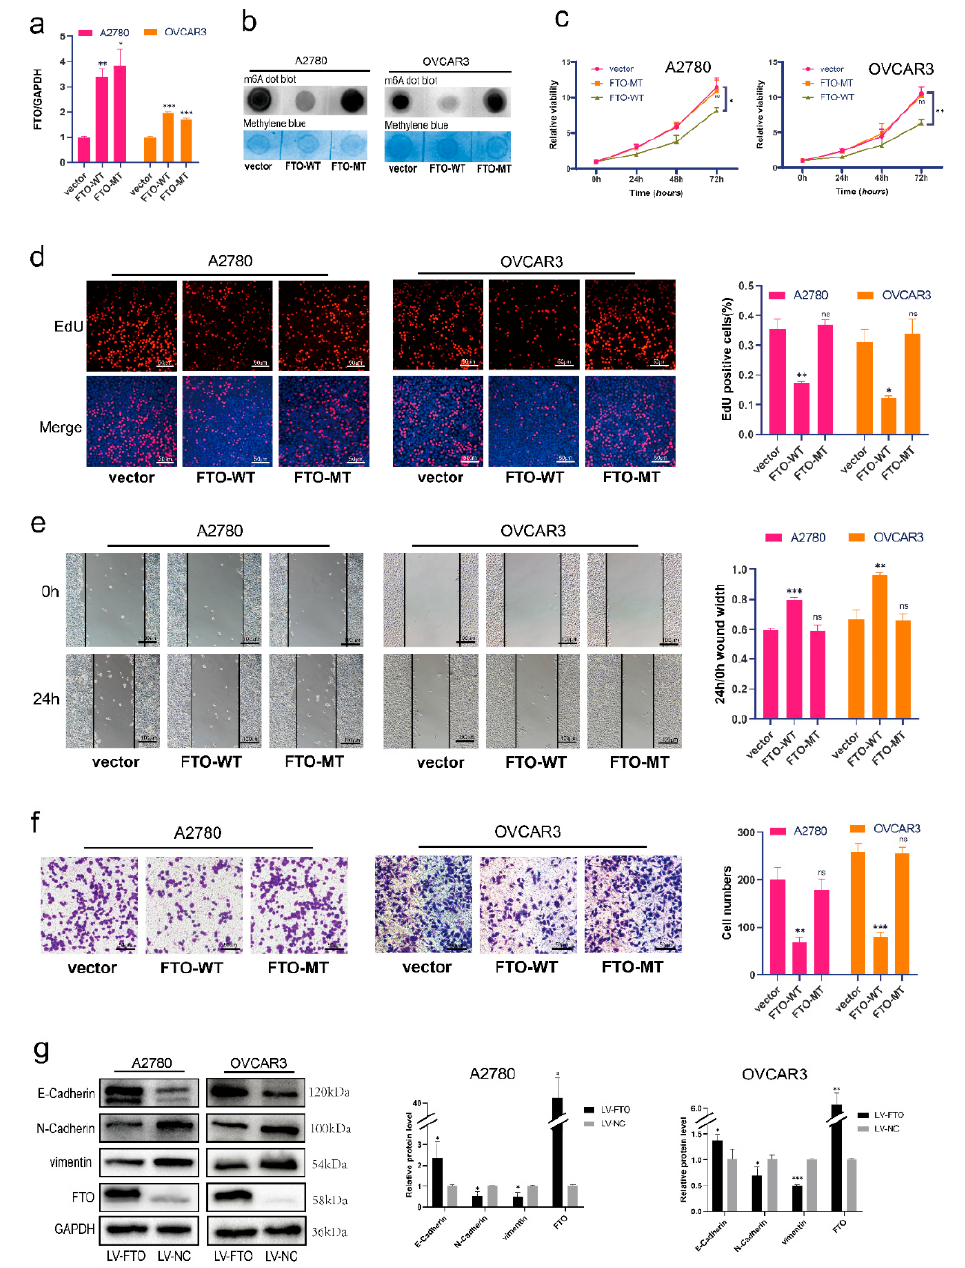
Figure 3. FTO overexpression inhibits malignant phenotypes of EOC cells in vitro. ( a ) RT-qPCR verified the efficiency of FTO-WT and FTO-MT overexpression in A2780 and OVCAR3 cells. After overexpression of FTO-WT and FTO-MT in A2780 and OVCAR3 cells, ( b ) m6A levels were detected by m6A dot blot; ( c ) CCK-8 assays tested cell viability; ( d ) EdU assay examined cell proliferation; scale bar, 50 µ m; ( e ) The wound healing assay detected the migration; scale bar, 100 µ m; ( f ) Cell invasion was evaluated by transwell assay; scale bar, 50 µ m; ( g ) Expression of N-cadherin, E-cadherin, and vimentin in A2780 and OVCAR3 cells was determined by Western blot. The data represent the results of three independent replicates. Data are presented as mean ± SD; ns, not significant; * p < 0.05; ** p < 0.01; *** p < 0.001. The uncropped blots are shown in Supplementary Materials File S1